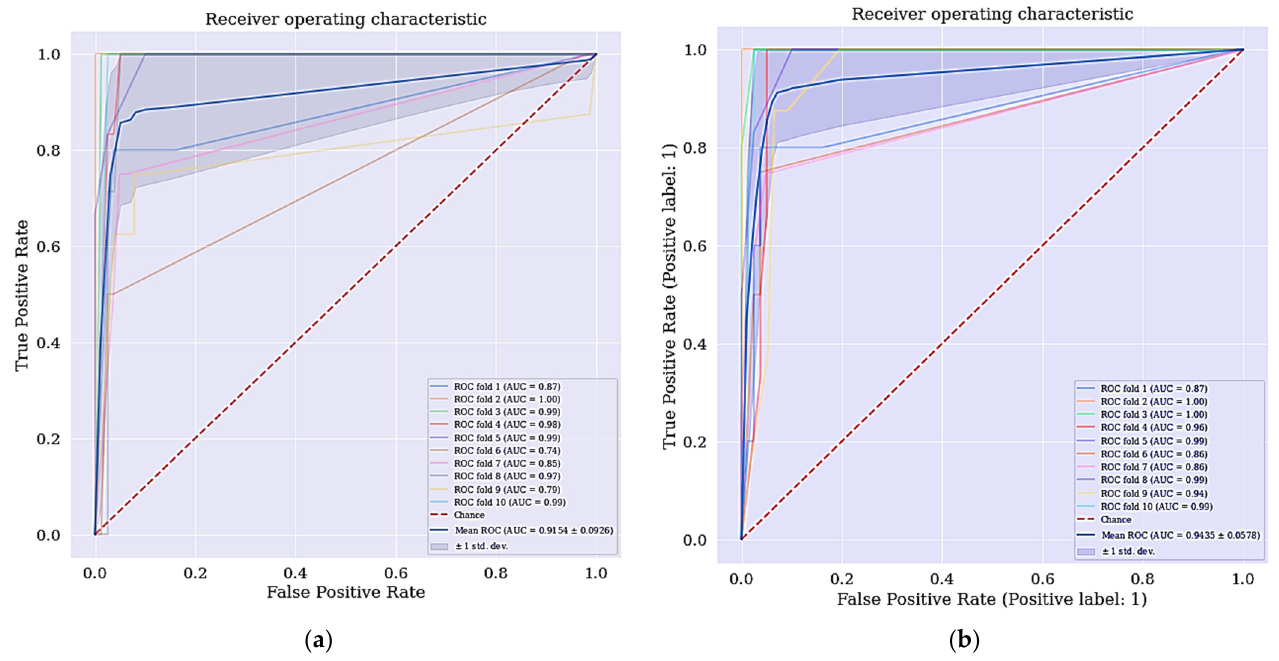
Figure 5. ( a ) ROC curve for DT + RFE; ( b ) ROC curve for DT + LASSO.